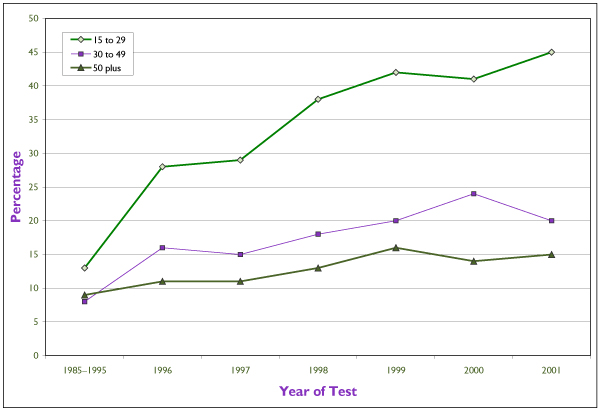
Proportion of Women among Adult (≥ 15 Years) Positive HIV Test Reports, by Age Group and Year of Test (1985/95–2001) Source: Data from HIV and AIDS in Canada, Surveillance Report to December 31, 2001.